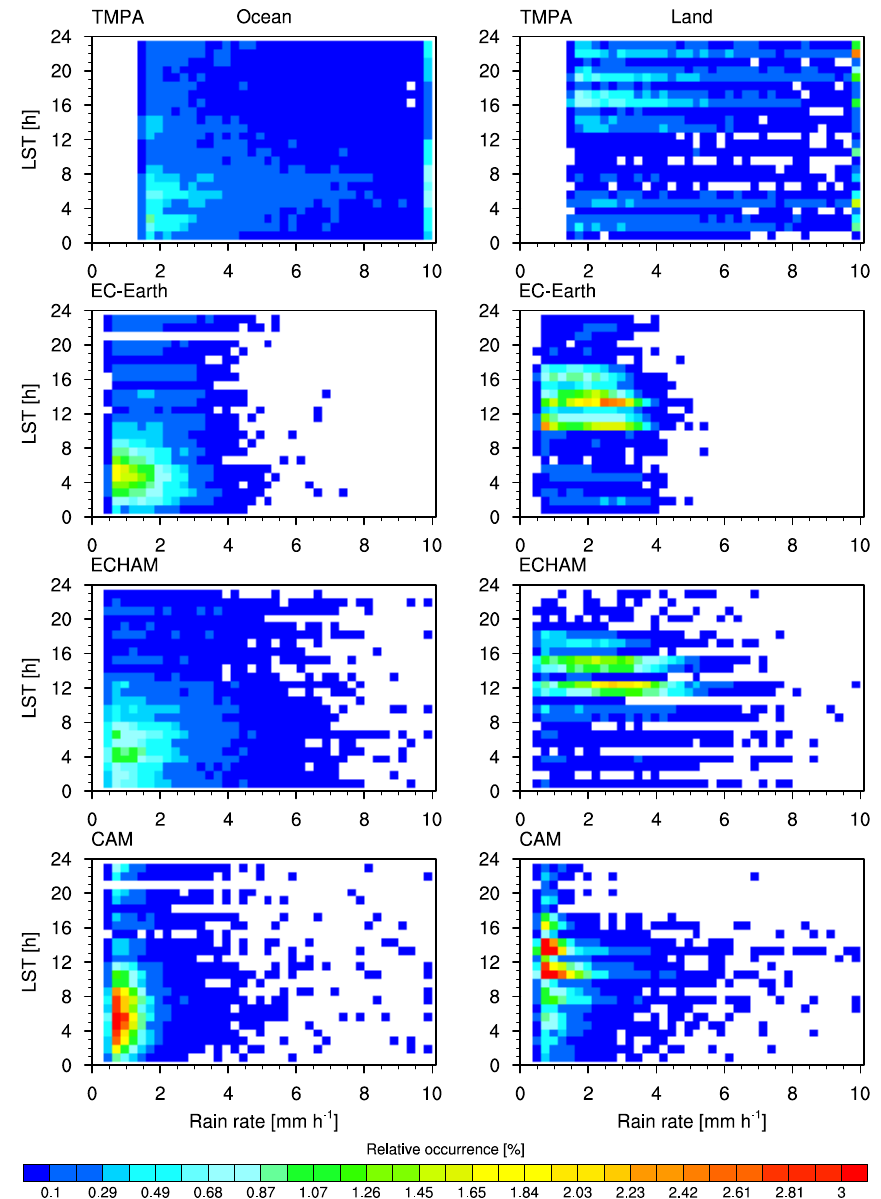
Figure 3. Relative occurrence of selected DC systems as a function of rain rate (RR) and the local solar time (LST) of peak convection (i.e. the timing of “0h” in the composite analysis). The results are given for Tropical Rainfall Measuring Mission Multi-satellite Precipitation Analysis (TMPA), EC-Earth3, ECHAM6, and CAM5. The RR bin size is set to 0.25mmh − 1 and 1h. The empty space for the lowest RR reflects the respective threshold values for the DC systems. The TMPA RRs above 10.0mmh − 1 are mapped to 10.0mmh − 1 to reduce the spread of the data along the x